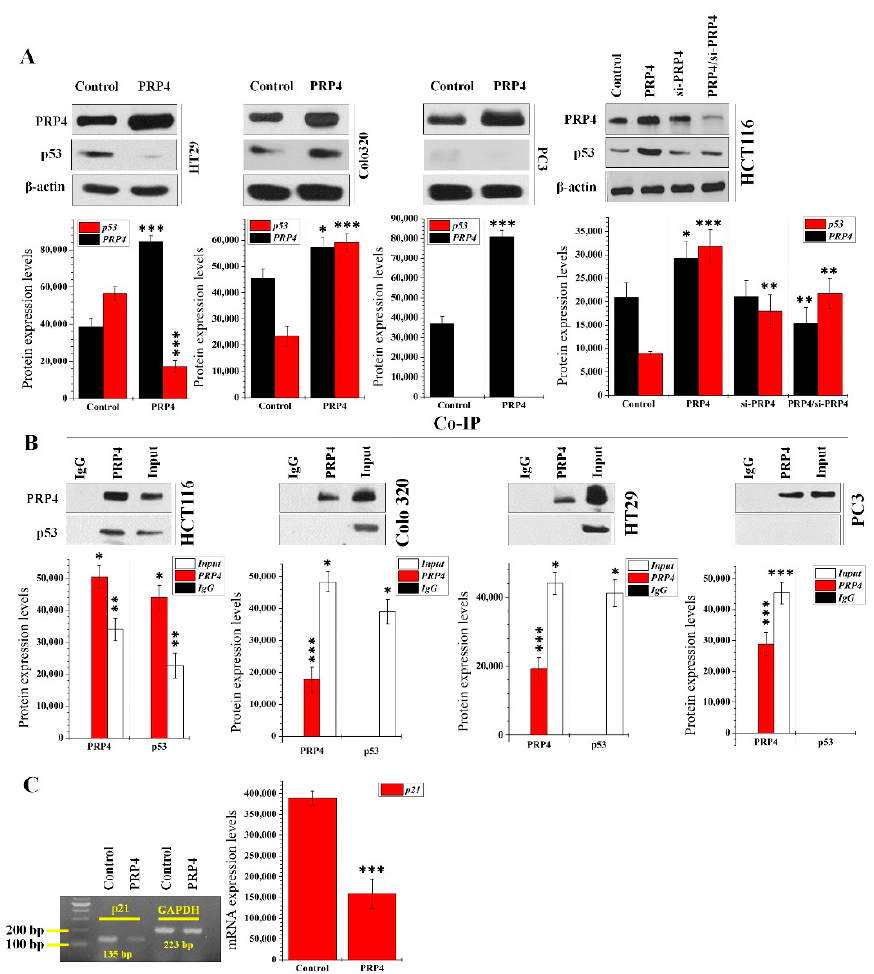
Figure 1. Interaction between PRP4 and p53: ( A ) Cell extracts from control and PRP4/si-PRP4 transfected groups were analyzed by Western blot with actin as a loading control. Data were collected from three independent experiments. * p < 0.05, ** p < 0.01, and *** p < 0.001. PRP4, transfection of PRP4 plasmid; si-PRP4, transfection of siRNA-PRP4; PRP4/si-PRP4, transfection with PRP4 plamsid and si-RNA-PRP4; ( B ) coimmunoprecipitation of p53 with an anti-PRP4 antibody. Samples of input (3% of total) and 30% of proteins from IP with antibody against PRP4, or control IgG from extracts of HCT116, Colo-320, HT29, and PC3 cells (1 mg) were separated by SDS-PAGE before reaction of Western blots with indicated antibodies. Data were collected from three independent experiments.